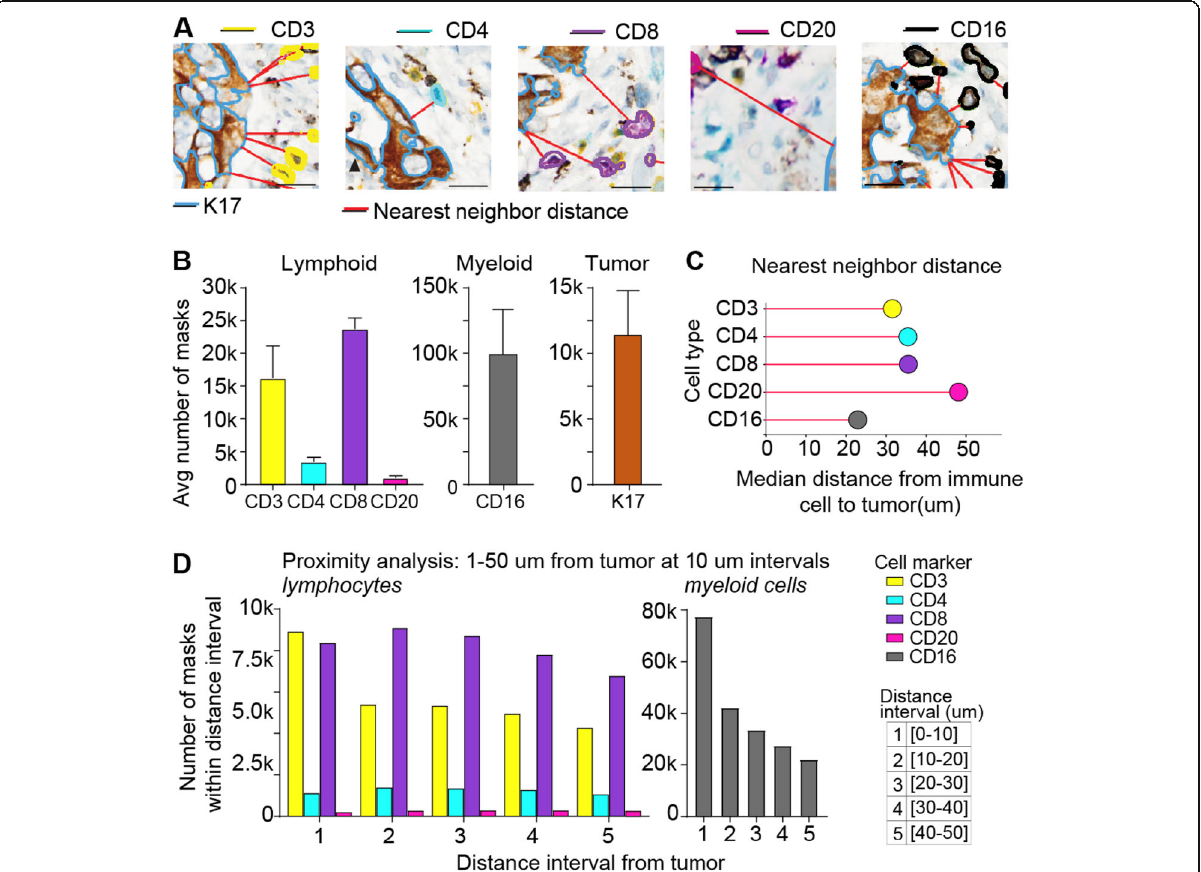
Fig. 6 Example of analyses describing immune-tumor spatial relationships in mIHC-stained PDAC tissue. a Representative images of segmentation boundaries of detected tumor nests and immune cells labelled with IHC biomarkers: K17 (blue segmentation boundary), CD3 (yellow boundary), CD4 (teal boundary), CD8 (purple boundary), CD20 (magenta boundary), and CD16 (black boundary). Red lines indicate nearest neighbor distance vector connecting each immune cell to the nearest tumor nest. b Average number of masks per case for each of the different cell classes in three WSIs. c Median nearest neighbor distances for each immune cell class across cases. d Proximity analysis showing the number of detected masks for each cell class at 10 um distance intervals from the tumor boundary. *Note: Nearest Neighbor analyses are asymmetric and Nearest Neighbor analyses from each tumor nest to nearest immune cell are shown in supplemental Fig.